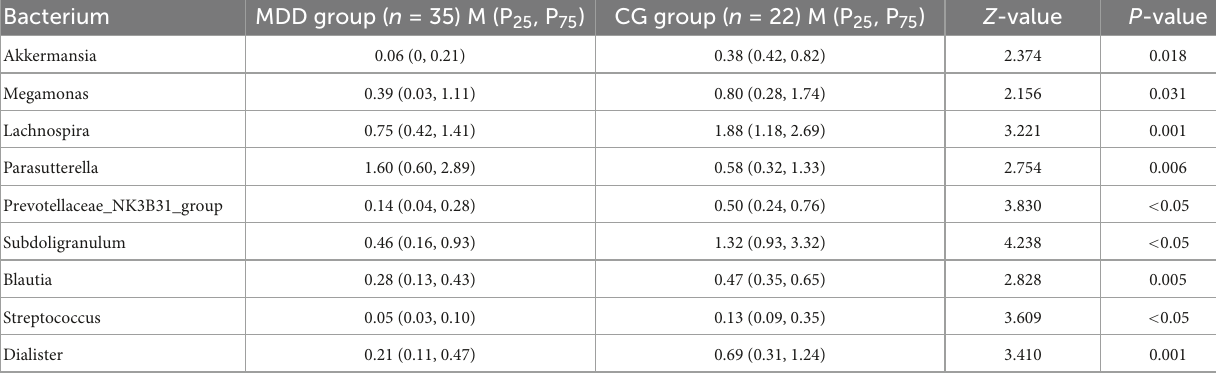
TABLE 3 Comparison of abundance of key bacterial genera at genus